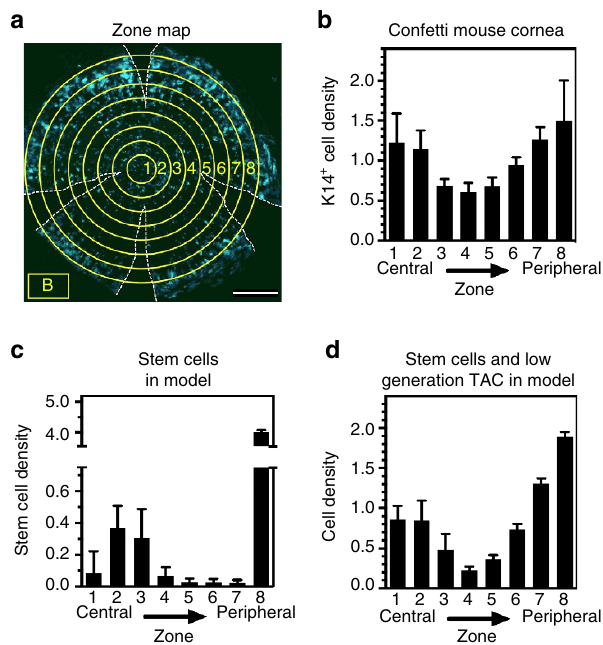
Figure 5 | The distribution of stem cells in a mouse corneal lineage tracing model is consistent with stem cell leakage from the limbus. The fluorescence images of corneas of K14CreERT2-Confetti mice ( a , b ) or simulation images ( c , d ) were divided into concentric zones and the density of the labelled cells was determined in each zone by calculating fluorescence intensity using ImageJ software. The cell density for each zone was normalized to the cell density of the entire cornea. ( a ) Confocal micrograph of a flat-mount of a representative cornea from an 8-week-old K14CreERT2-Confetti mouse, showing only the cyan channel. The mouse had been induced to undergo recombination 2 weeks earlier by the injection of tamoxifen. The gaps in the cornea created by the cuts made to flatten it for imaging are indicated by dotted lines. The concentric zones used to quantify the distribution of labelled cells (numbered 1–8) and the region used to adjust for background fluorescence (B) are indicated in yellow. Scale bar, 500 m m. ( b ) Quantification of the density of labelled cells per unit area within the different zones of the mouse cornea shown in a . A bimodal distribution of the cells, with peak densities at the periphery and near the centre, is evident. The mean ± s.d. of the distributions of the four colour channels (cyan, green, yellow and red) are shown. ( c ) Distribution of stem cells (combining limbal and corneal stem cells) in the simulated corneas at t ¼ 1,000 with a stem cell leakage rate of 10%. The mean and s.d. of 10 simulations is shown. ( d ) The same simulated corneas as in c were re-analysed to account for low-generation TACs that would be labelled during the 2 weeks post tamoxifen in lineage tracing corneas such as that used in a and b . The data shown are the mean ± s.d. of the sum of stem cells and TAC generations 1–3.